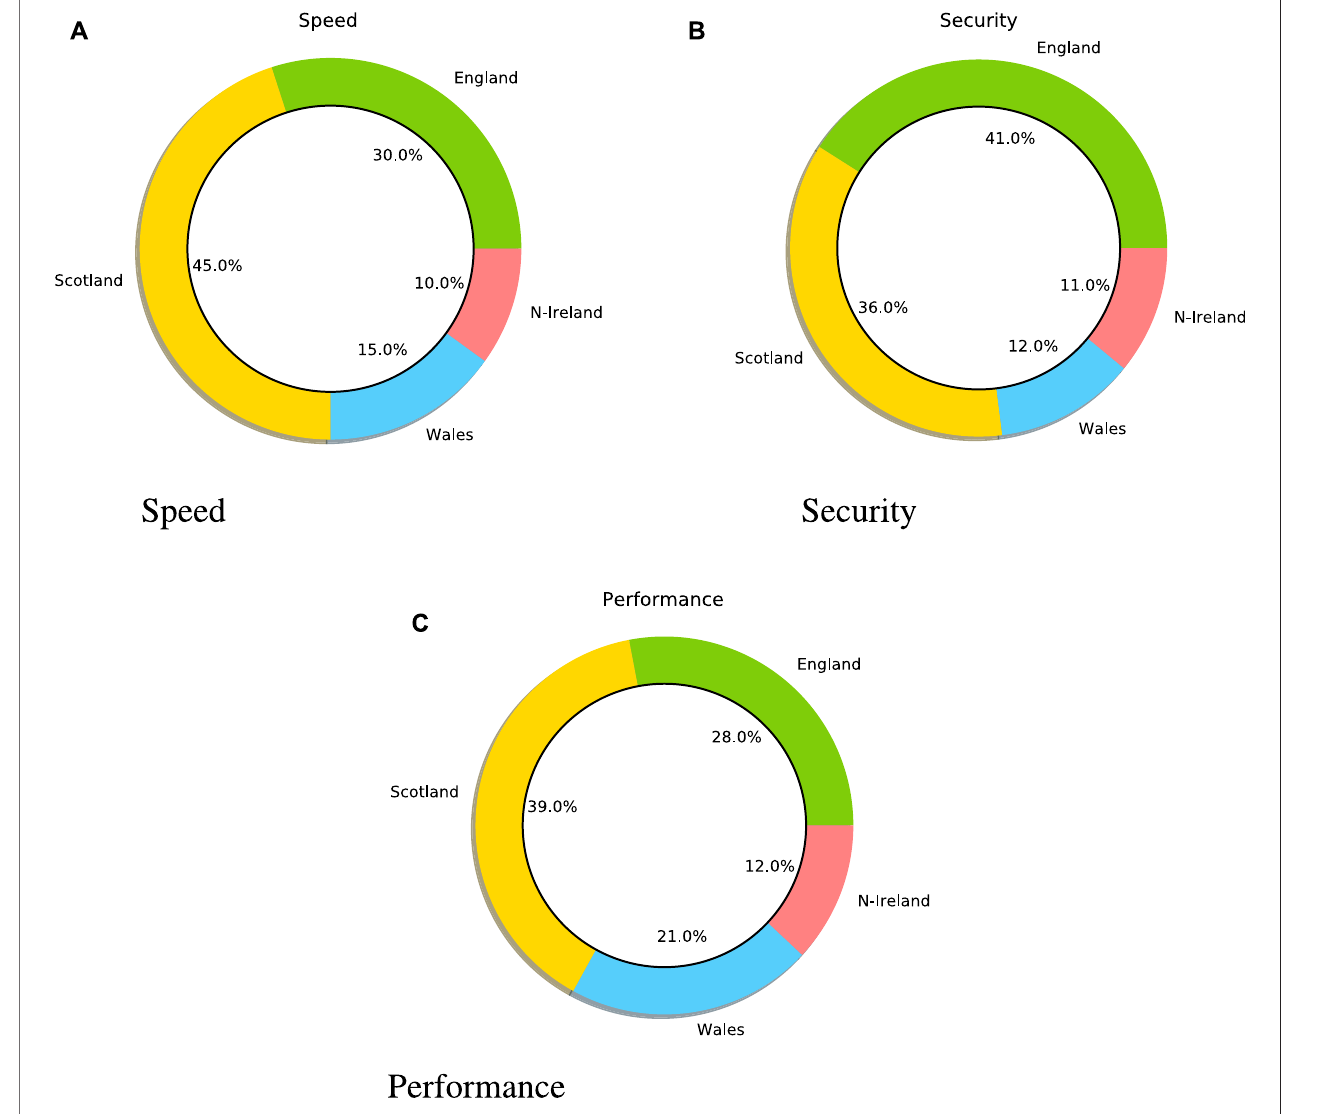
FIGURE 2 | Positive trends towards the fi fth generation of cellular networks (5G).